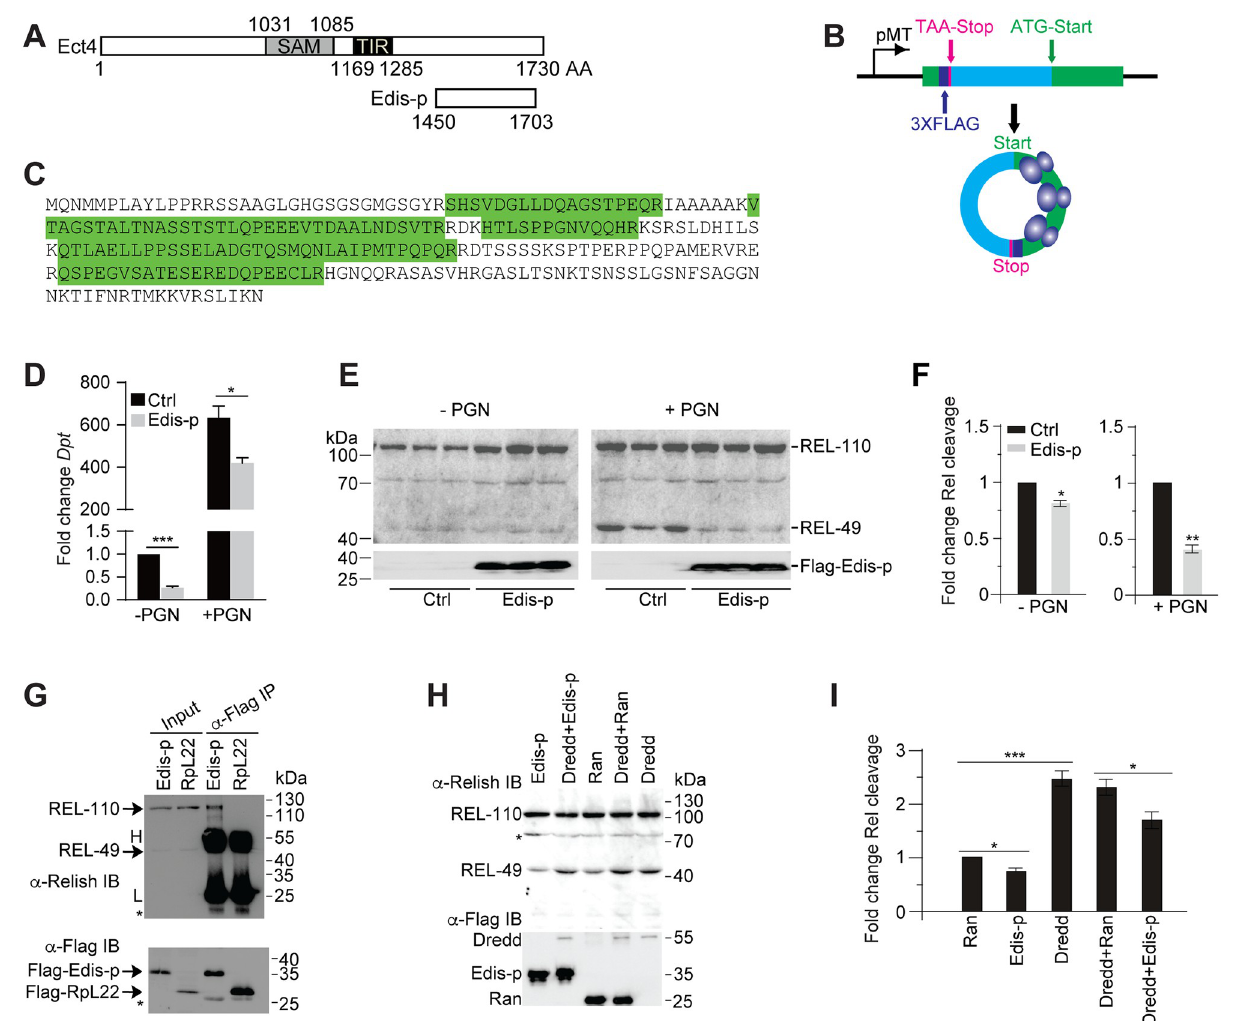
Fig 6. Edis encodes a functional protein. ( A ) Schematic of the Ect4 and Edis-p proteins. Positions of the SAM (sterile alpha motif) and TIR (Toll/ interleukin-1 receptor homology) domains are shown. ( B ) Schematic of the Edis minigene driven by the metallothionein promoter. The longest ORF, which encodes a potential protein product (Edis-p) derived from Edis , and the corresponding UTR are shown in green and blue, respectively. Positions of the initiation codon and stop codon are noted. A 3X FLAG epitope tag-coding sequence was placed immediately upstream of the putative stop codon. ( C ) Lysate from stably transfected S2 cells carrying the constructs described in B was subjected to anti-FLAG IP followed by mass spectrometry. Five independent peptides (in green) derived from the Edis-p were identified. ( D ) S2 cells were transfected with empty vector or the expression construct encoding Flag-tagged Edis-p. Cells were first treated with copper and 20-HE. Subsequently, cells were treated with PGN or left untreated. Levels of the Dpt transcript were measured by RT-qPCR (student t test, n = 3, � p < 0.05; ��� p < 0.001). ( E-F ) S2 cells were transfected with empty vector or the expression construct encoding Flag-tagged Edis-p. Cells were first treated with copper and 20-HE. Subsequently, cells were treated with PGN or left untreated. Cell lysates were subject to immunoblot using anti-Relish (upper panel) or anti-Flag (lower panel) antibodies. Quantification of Relish immunoblot in E is shown in F (student t test, n = 3, � p < 0.05; �� p < 0.01). ( G ) Lysates from stably transfected S2 cells expressing either Flag-Edis-p or Flag-RpL22 (control) were subjected to anti-Flag immunoprecipitation. Subsequently, the immune-purified anti-Flag samples, together with input lysates, were analyzed by immunoblot in parallel using antibodies against Relish (upper panel) and Flag (lower panel). Non-specific bands (asterisks), heavy (H) and light (L) chains are also labeled. ( H ) S2 cell lysate (containing endogenous Dredd and Relish) was incubated with various combinations of purified recombinant Flag-Edis, Flag-Ran and Flag-Dredd in a Relish processing reaction at 30˚C for 2h. The reactions were subsequently subjected to immunoblot analysis using anti-Relish and anti-Flag antibodies. ( I ) Quantification of Relish processing in H (student t test, n = 3, � p < 0.05; ��� p <